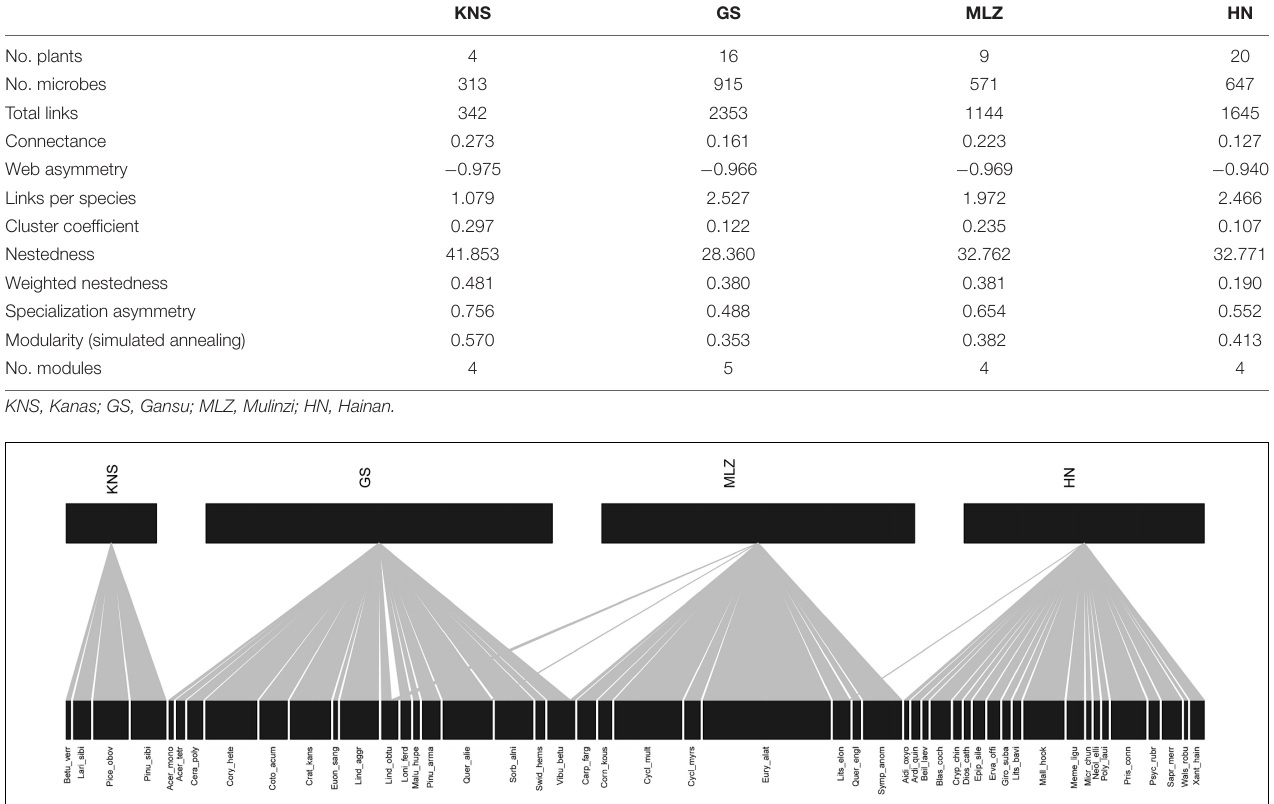
TABLE 1 | Network topological structural properties of the plant–bacteria network. KNS GS MLZ HN